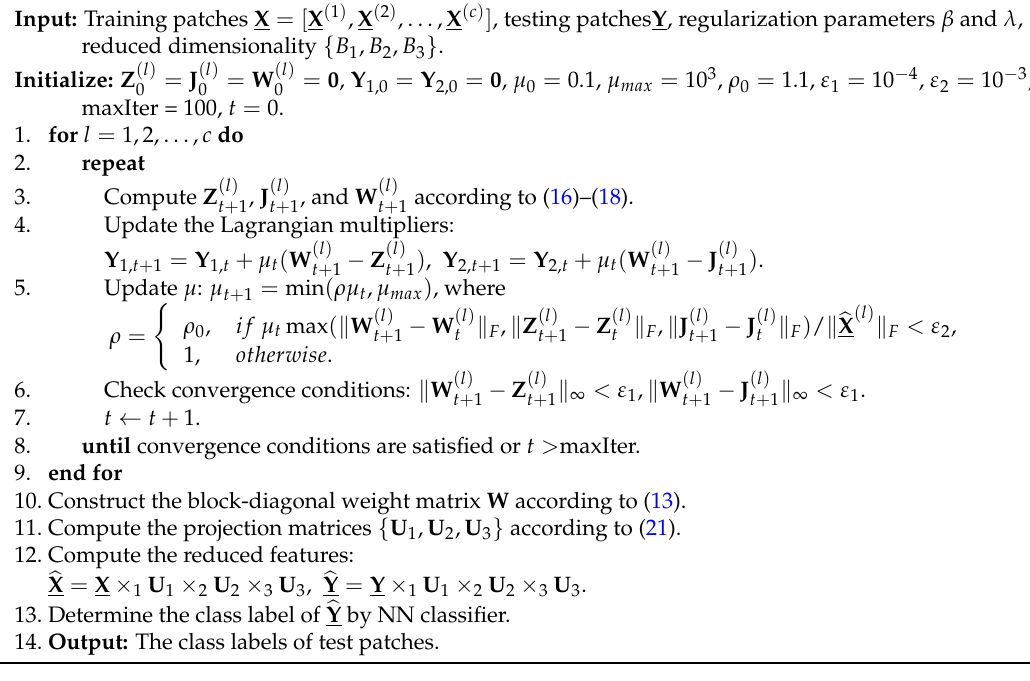
Algorithm 1: Tensor Sparse and Low-Rank Graph-Based Discriminant Analysis for